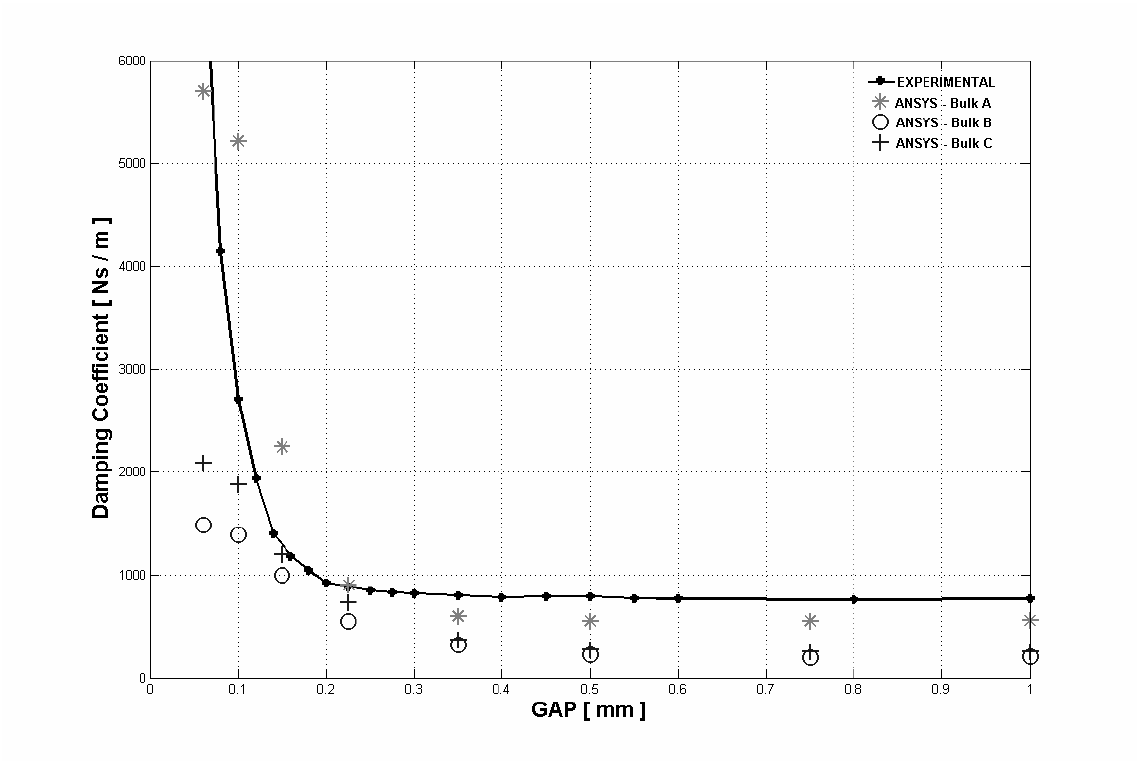
Fig. 10. Comparison between the simulated and experimental results for 5 Hz